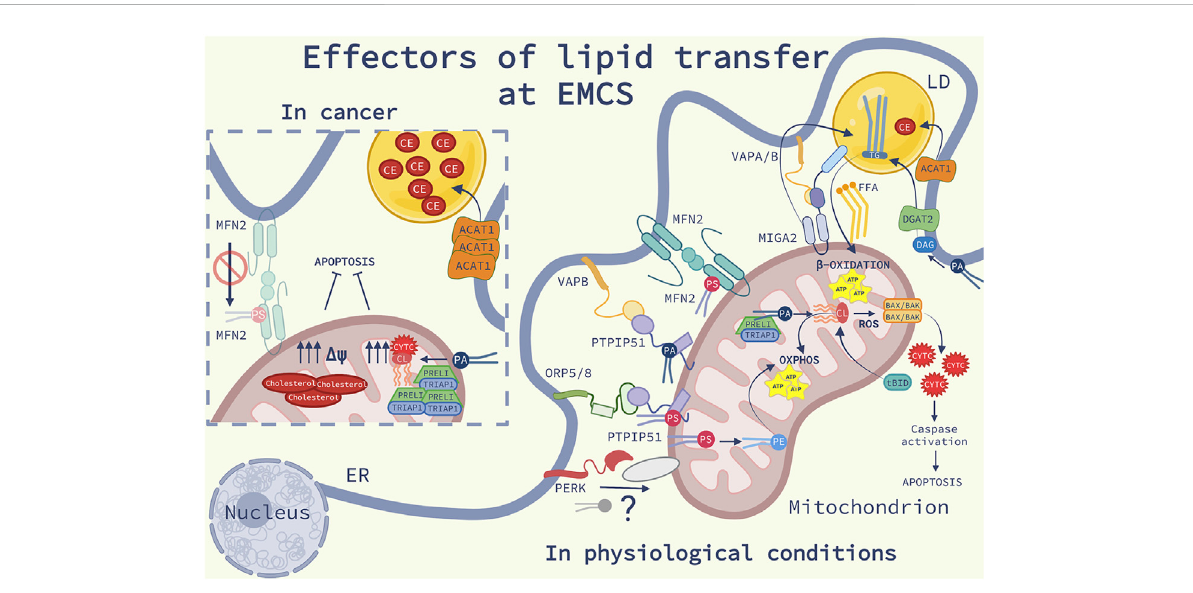
FIGURE 2 EffectorsoflipidtransferatEMCS:SchematicrepresentationofthelipidhomeostasisatER-mitochondriacontactsites(EMCS)andlipiddroplets (LD), in physiological conditions (on the right) and in cancer (on the left). On the right side of the image, are represented the main lipid transfer proteins (LTP) discussed in the review (see the main text for further explanations); Mitofusin 2 (MFN2) homodimers, bind and transfer phosphatidylserine (PS), the oxysterol-binding protein-related protein (ORP) 5 and 8-protein- tyrosine phosphatase interacting protein 51 (PTPIP51) complex, the vesicle-associated membrane protein-associated protein B (VAPB)- PTPIP51 complex, responsible of the transfer of phosphatidic acid (PA). The Ser/Thr kinase RNA-dependent protein kinase (PKR)-like ER kinase (PERK) is shown to interact with an unknown mitochondrial protein, possibly facilitating phospholipid (PL) transport. In the inner mitochondrial membrane (IMM) PS is converted into PE and PA and transferred into the mitochondrial intermembrane space (IMS) by TP53-regulated inhibitor of apoptosis gene 1 TRIAP1-PRELI complex. PA is converted into cardiolipin (CL), an anionic PL which promotes mitochondrial oxidative phosphorylation (OXPHOS). In response to cell death stimuli, CL interacts with truncated BH3 interacting-domain death agonist (tBID) promoting BAX/BAK oligomerization, release of cytochrome c (CYTC), triggering caspase activation and apoptosis. Mitoguardin 2 (MIGA2)-VAPA/B complex tethers the EMCS to LD and facilitates the production of triglycerides (TG). TG is synthesized into the ER from PA via the diacylglycerol acyltransferase 2 (DGAT2) enriched at EMCS. The enzyme acyl-CoA cholesterol acyltransferase-1 (ACAT1) localized at EMCS synthetizes cholesteryl esters (CE). TG and CE are stored in LD. TG hydrolysis provides free fatty acids (FFA) as fuel for β -oxidation occurring in the mitochondria. On the left panel, some molecular mechanisms involving lipid signaling at EMCS,whicharealteredincancercells,areillustrated:ACAT1expressionisincreased,consequentlyleadingtotheaccumulationofelevatedlevelsof CE into LD; the complex TRIPA1-PRELI is upregulated, PA is converted into CL, impairing the release of CYTC and the sensitivity to apoptosis; cholesterol is highly accumulated into the IMM, affecting the mitochondrial potential ( Δψ ) and favoring resistance to apoptosis. De fi ciency of MFN2 compromises the transferring of PS at EMCS causing ER stress, in fl ammation, fi brosis and